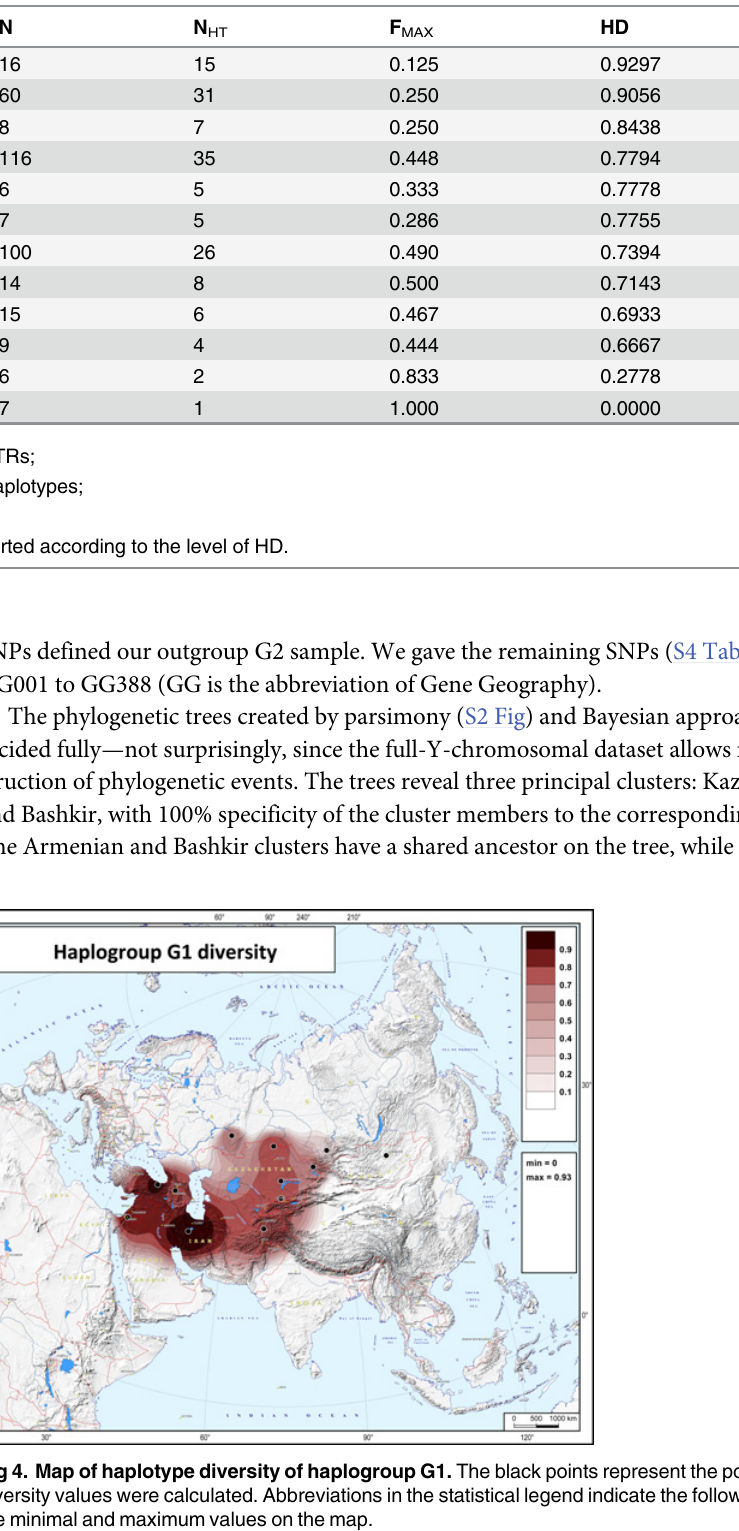
Table 2. Haplotype diversity of haplogroup G1-M285 in South-Western and Central Asian populations.